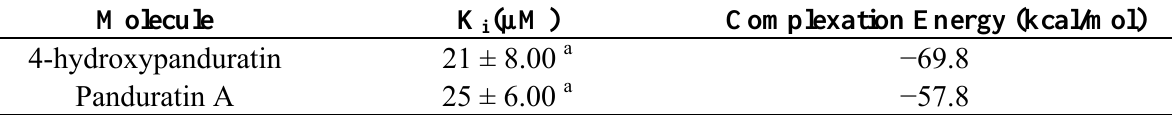
Table 1. The complexation energies of 4-hydroxypanduratin A and panduratin